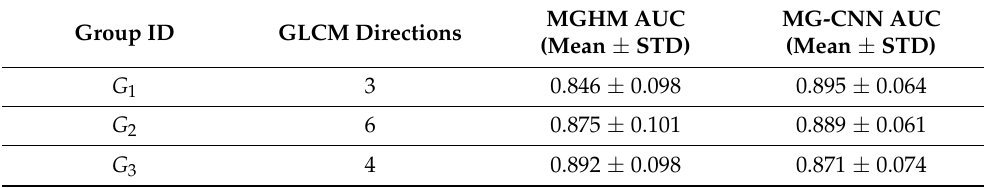
Table 4. The preliminary classification results of the two proposed